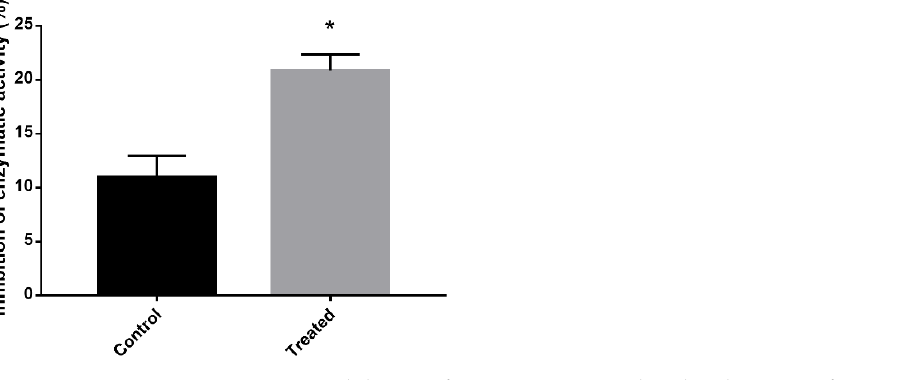
Figure 6. SOD enzymatic activity inhibition after exposure to mebendazole. Quantification of the level of inhibition of SOD expression in cells exposed or not exposed to mebendazole. The * indicates a significant difference between the control and treated samples, with a p value ≤ 0.05. The error bar represents the deviation between the biological triplicates.